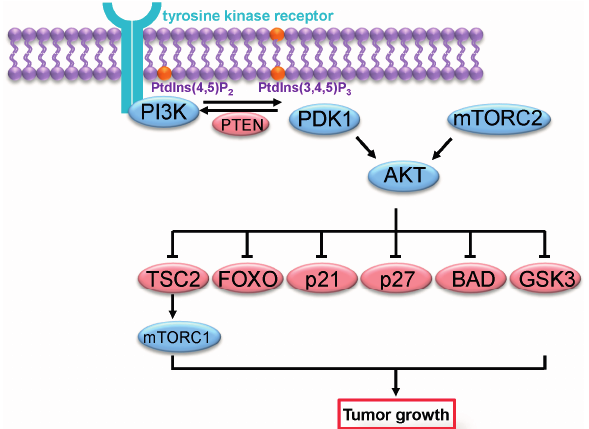
Figure 1. PI3K/AKT signaling pathway. Following its activation by tyrosine kinase receptors, PI3K catalyzes the phosphorylation of PtdIns(4,5)P 2 (phosphatidylinositol 4,5-bisphosphate) to PtdIns(3,4,5)P 3 (phosphatidylinositol 3,4,5-trisphosphate), resulting in the recruitment